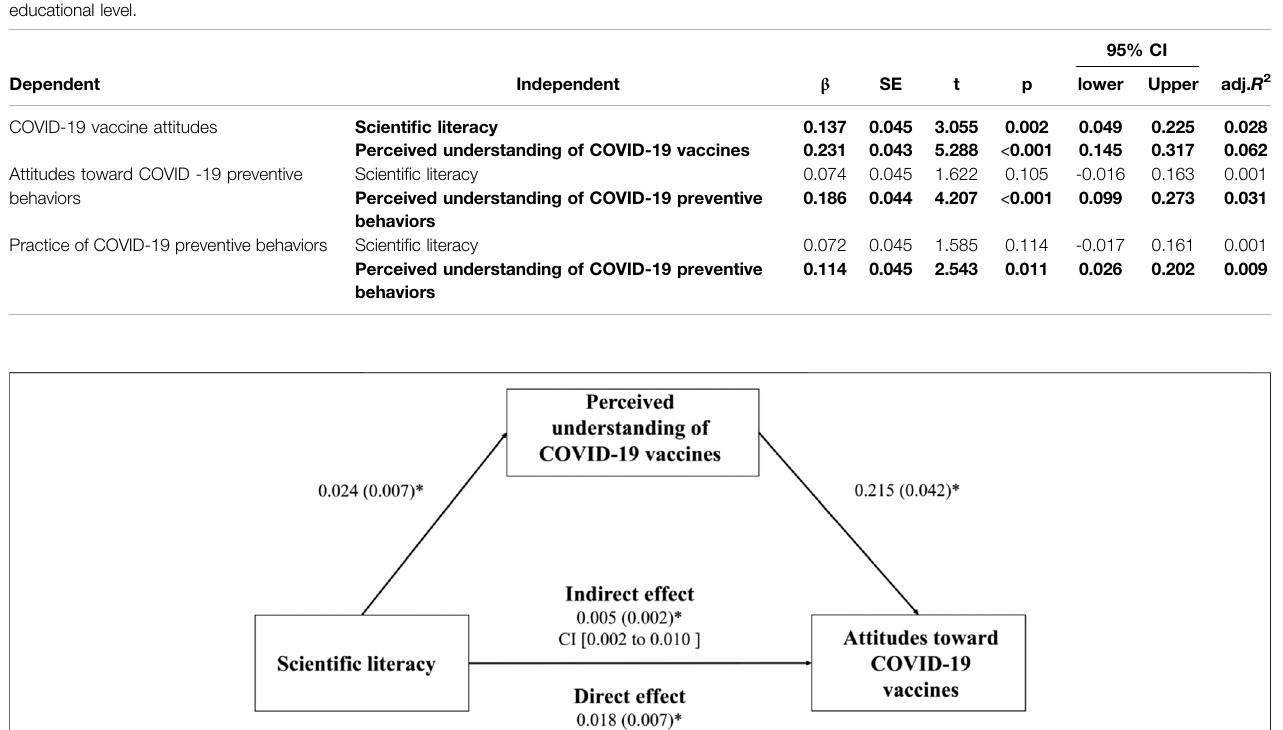
Frontiers in Communication |